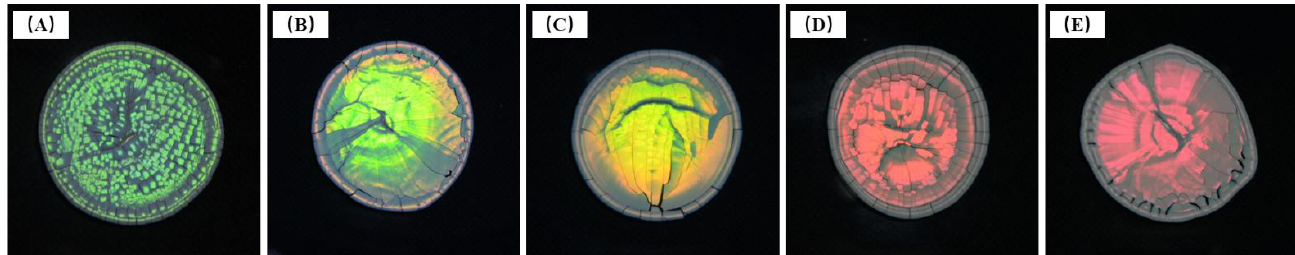
Figure 12. Photos of dried samples of P(St-AA) colloidal microspheres synthesized with different reaction temperatures: ( A ) 65 °C; ( B ) 70 °C; ( C ) 75 °C; ( D ) 80 °C; ( E ) 85 °C.